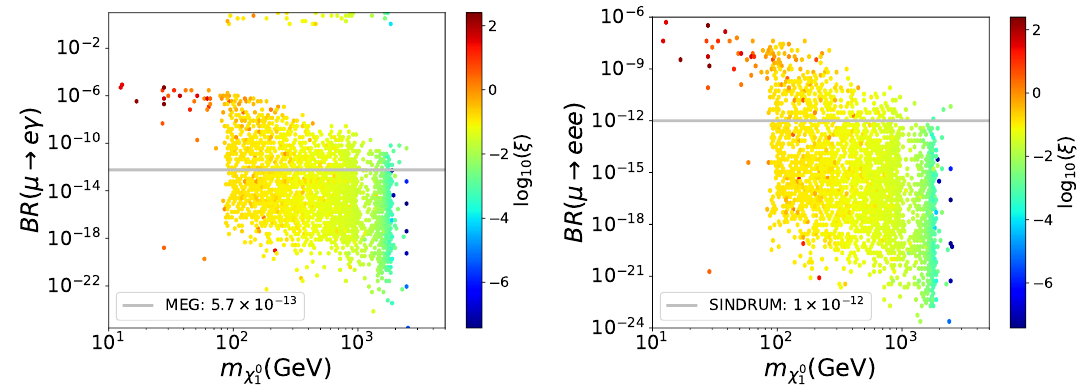
Figure 6 . Left: (cid:22) e(cid:13) values for the scan of the parameter space. The grey line show the current ! limit [50]. The upper region is excluded. Right: (cid:22) 3 e values for the scan. The grey line shows ! the current limit [51].